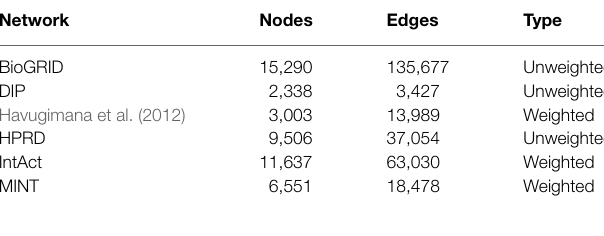
TABLE 1 | Features of PPI networks integrated in SPECTRA . Network Nodes Edges Type BioGRID